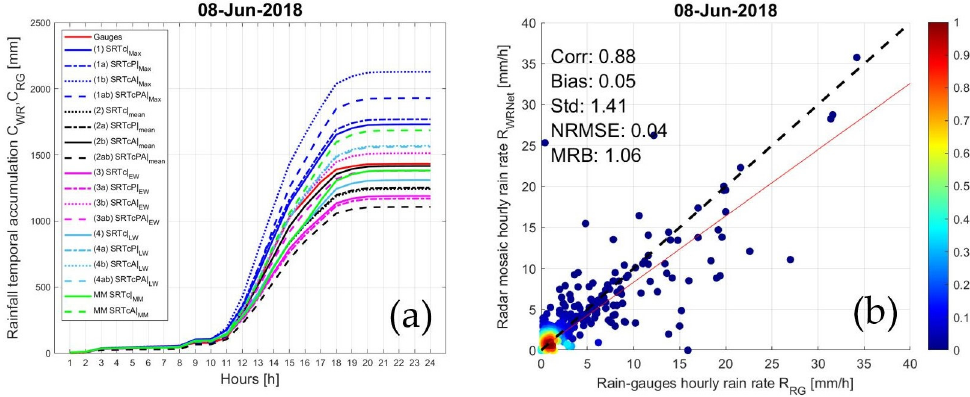
Figure 10. ( a ) Time series of rainfall temporal accumulation (see Equation (7)), based on rain-gauge data (C RG ) and weather radar mosaic data (C WRNet ) with different mosaicking techniques, for the event occurring on 8 June, 2018. For comparison, the rainfall temporal accumulation from MM single-radar (with and without anisotropic correction) is also shown. See Table 3 for the label legend meaning. ( b ) Scatterplot of radar mosaic hourly rain rate estimates R WRNet (see Equation (6)) and rain-gauge hourly rain rate R RG during the same event. The hourly rain rate R WRNet (see Equation (5)) from the weather radar mosaic is obtained by means of the average method (label 2b in Table 3). The maximum-value approach (ID = 1 in Table 3 with all its variants, blue lines) is